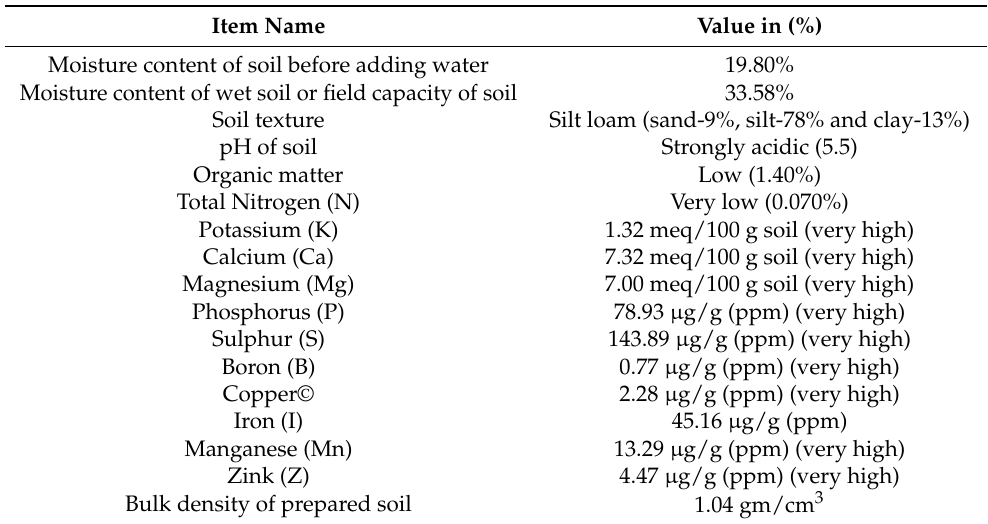
Table 2. Physical and chemical characteristics of growing medium